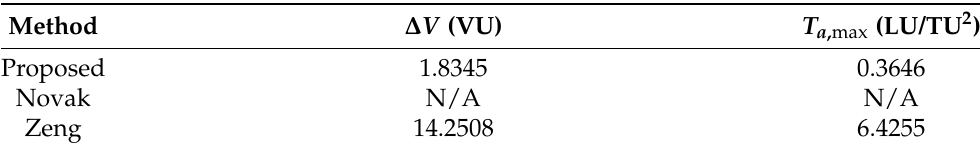
Table 5. Orbit rendezvous results when r 1 > r 2